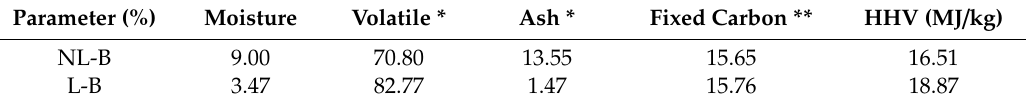
Table 2. Proximate analysis of leached and non-leached biomass samples. Parameter (%)